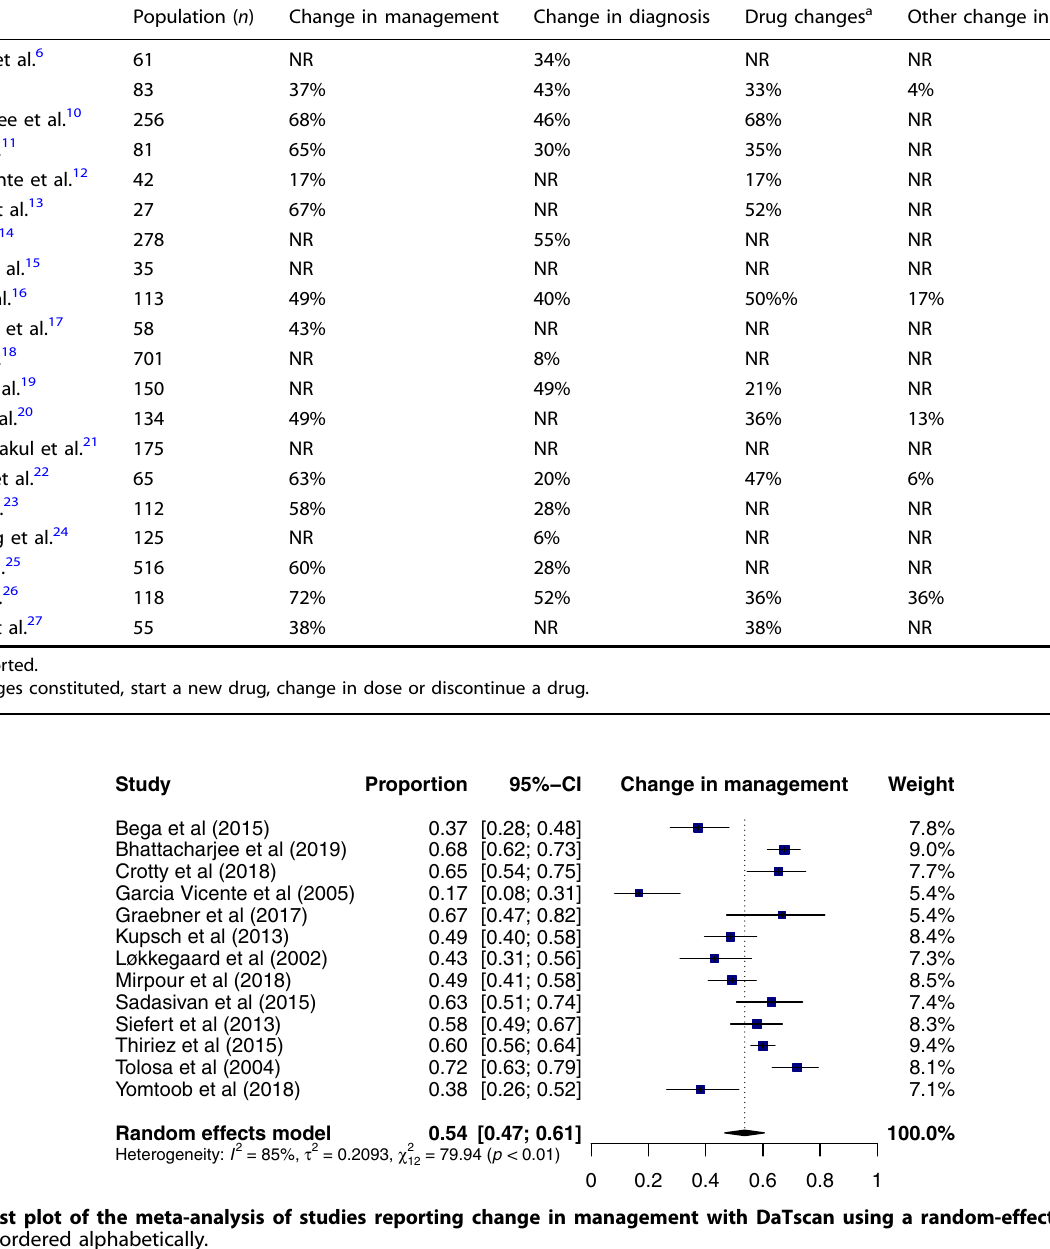
Table 2. Study outcome data for change in management and diagnosis. Study Population ( n )